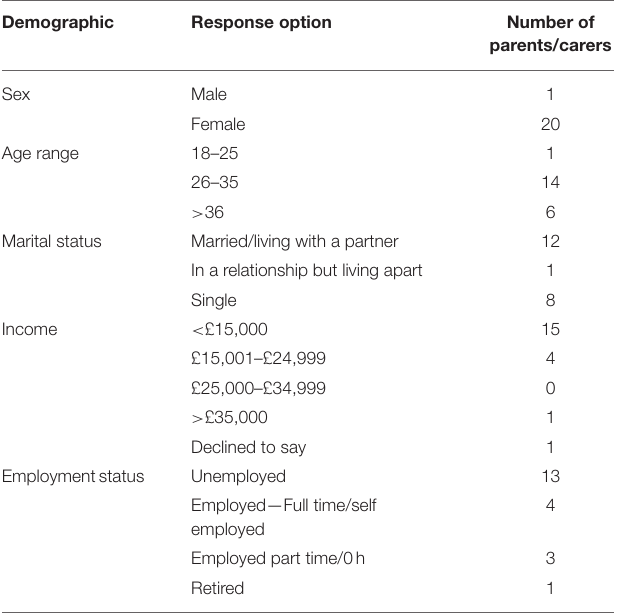
TABLE 1 | Demographic characteristics of